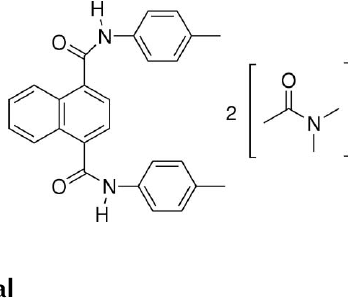
Experimental Crystal data